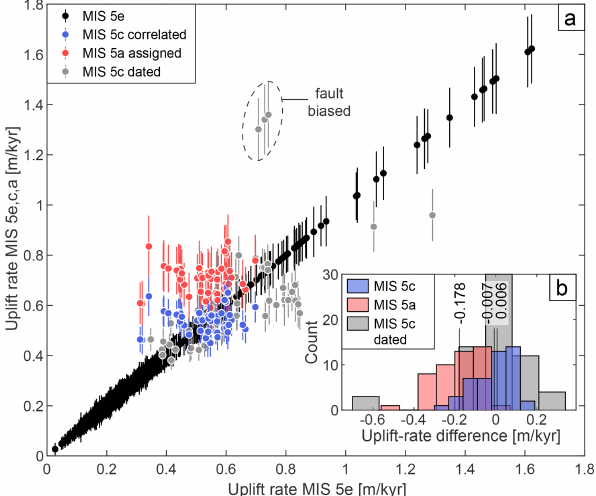
Figure 3. Comparison of MIS 5 uplift-rate estimates. (a) Uplift rates derived by correlating mapped terrace occurrences located im- mediately below the MIS 5e level to either MIS 5c (blue) or MIS 5a (red) with respect to MIS 5e uplift rates. Marine terraces correlated to MIS 5c by an age constraint are plotted in gray color. (b) His- tograms of differences between MIS 5a or MIS 5c uplift rates and MIS 5e uplift rates. Vertical lines show median uplift-rate differ- ences. See Sect. 2.2.2 for relative sea-level elevations of MIS 5a, 5c, and 5e.